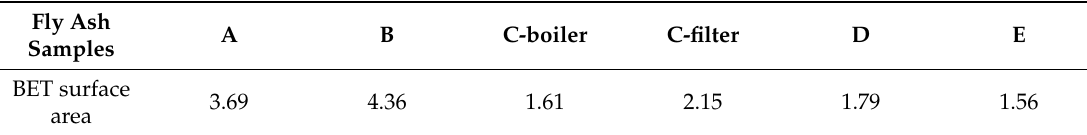
Table 2. BET surface areas of fly ash samples in m 2 / g.